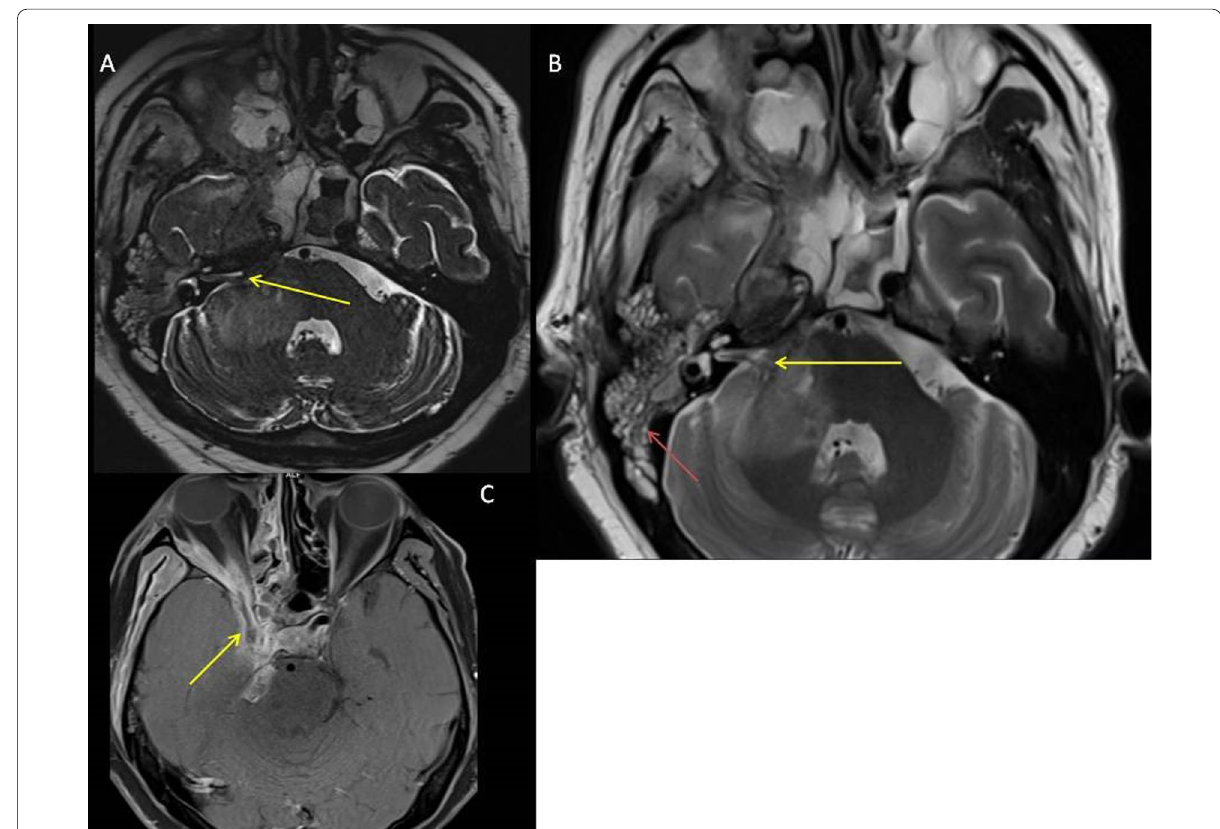
Fig. 9 A CISS, and B T2 WI sequence showing thickening of the cisternal segment of the seventh-eighth nerve complex on the left side. The underlying right middle cerebellar peduncle shows T2 hyperintense signal. Fluid signal is noted replacing the normal mastoid air cells on the right suggestive of mastoiditis (red arrow). Inflammation is noted along the floor of the left orbit and sphenoid sinusitis. C T1 WI post-contrast axial sequence showing abnormal enhancement along the right cavernous sinus extending into the